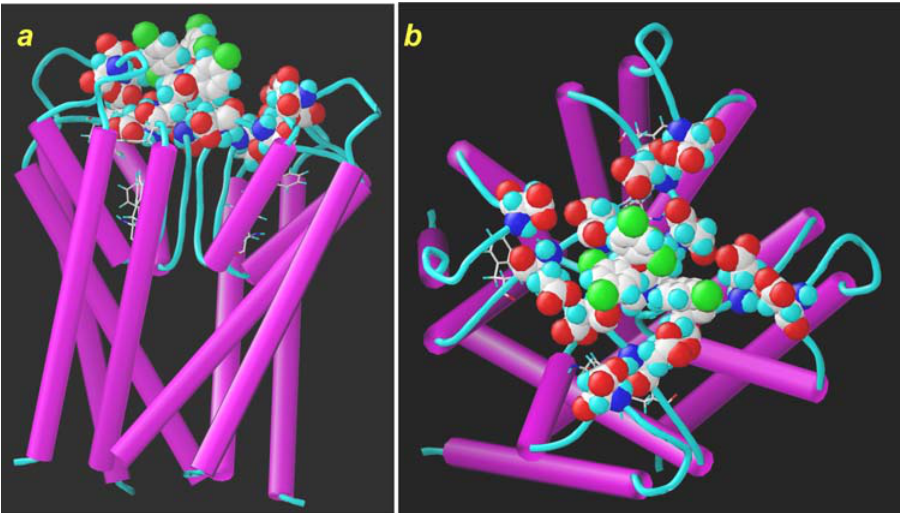
Figure 11. A docking of CMZ to pore loop domain of TRPV1. Symmetrical arrangement of the 5 and 6 TM helices (magenta) in the tetrameric TRPV1 receptor complex is shown. Aromatic residues within the 20 A˚´ proximity to the inhibitor are shown by sticks, and the Asp and Glu residues as well as the ligand by spacefilled models. Color codes for the atoms: grey, C; cyan, H; blue, N; red, O; green, Cl. The pore loop, localized in between transmembrane domain 5 and 6 of TRPV1 is shown with the specific docking site of the positively charged CMZ. ( a ) side-view and ( b ) a view perpendicular to the cell membrane were generated after docking of CMZ. Negatively charged ‘‘acidic domain’’ of TRPV1 in the homotetramer may serve as ideal nest for channel blockers such as CMZ . trifluoperazine . chlorpromazine/amitriptyline, as well as, ruthenium red and R 4 W 2 , all charged oppositely. The rule is that more basic is an anti- calmodulin substance that more attracted to the acidic moieties of the ‘‘nest’’ by electrostatic forces near to the entrance (i.e. ion filter) of the pore. It is a tendency that longer is the hydrophobic side chain tethered to the tricyclic core better is the fit inside the pore, such as determined with amitriptyline and